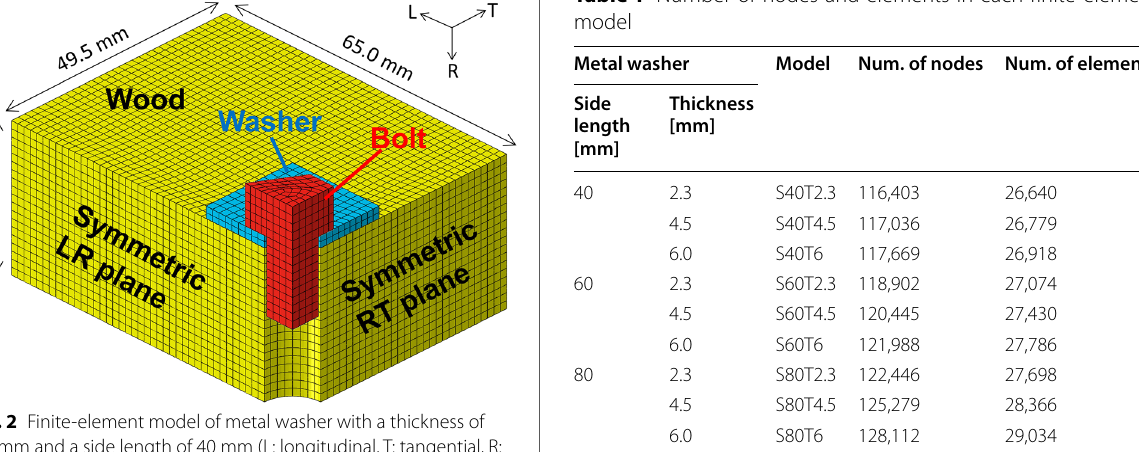
Table 1 Number of nodes and elements in each